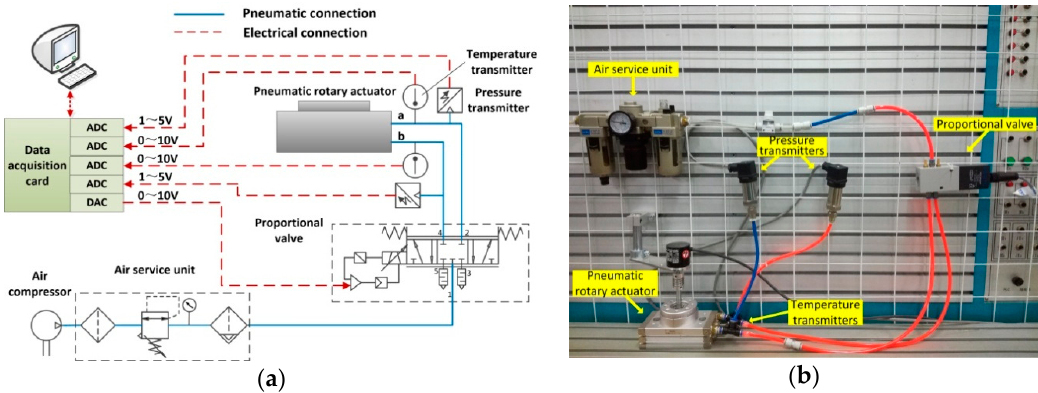
Figure 21. Pneumatic circuit for charging and discharging: ( a ) Schematic diagram; ( b ) Test platform.